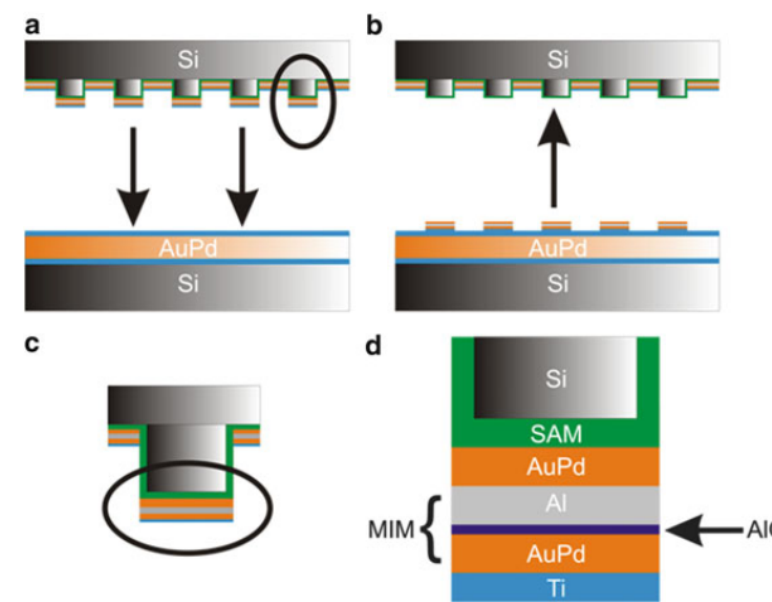
Figure 15. The nano transfer printing method. ( a ) shows how the stamp looks before the printing where diodes are still on the stamp protrusions; ( b ) since the organic self-assembled monolayer (SAM) in the figures provides weak adhesion to the stamp surface, the diodes are transferred to the substrate when the stamp is applied to the substrate; the diode stack between the stamps remains there without getting printed because it has no contact with the substrate surface; ( c ) close-up view of the stamp; ( d ) shows the diode stack up reaching the stamp protrusion (Reproduced with permission from [109], Springer,